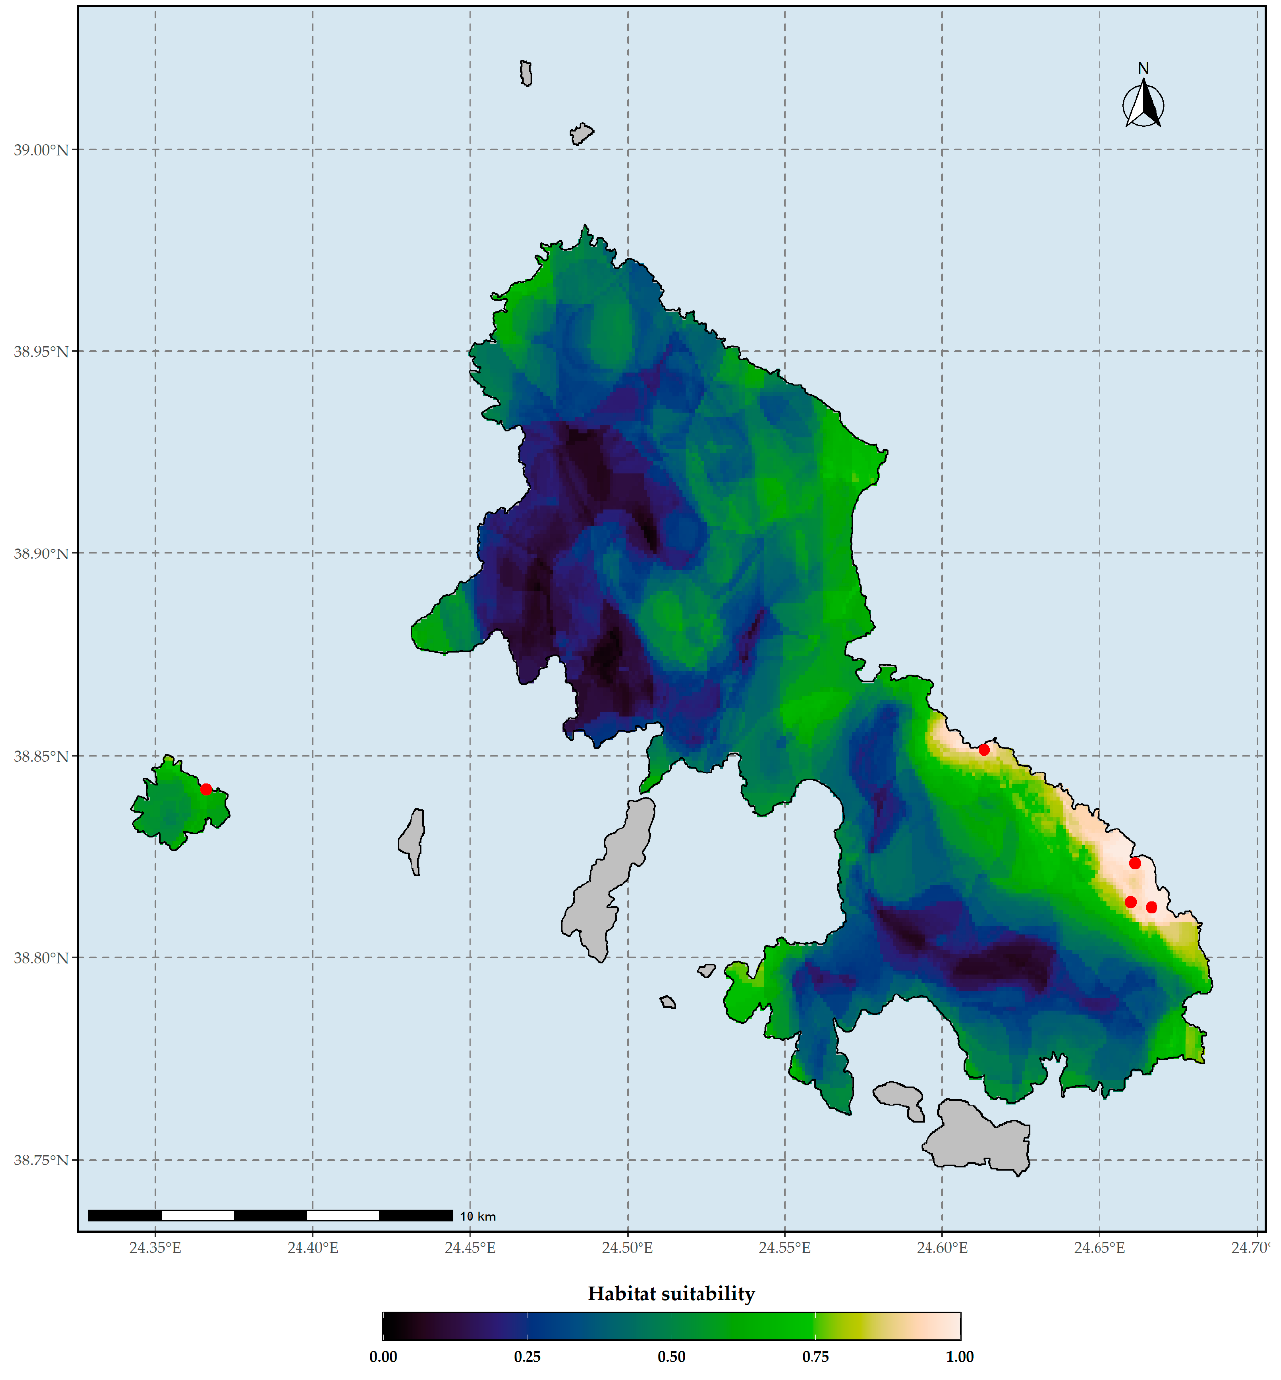
Figure 2. Habitat suitability map of Aethionema retsina under current climate conditions based on the WorldClim climate database. Red dots indicate the occurrences of Aethionema retsina in Skyros and Skyropoula. Threshold for binarization: 0.998.